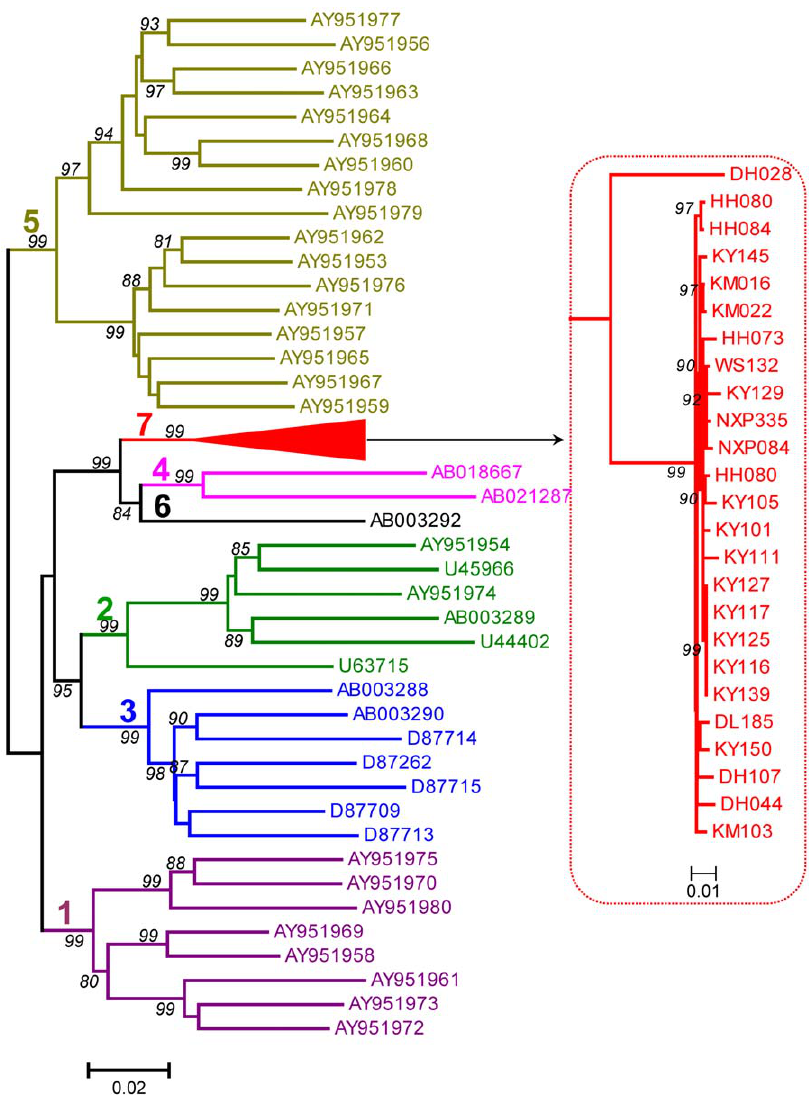
Figure 3. Phylogenetic tree reconstructed with GBV-C E2 region sequences. These sequences were each 1004 bp in length, corresponding to nt 610–1613 in the U36380 genome. Otherwise all the labels are as the same as shown in figure 2.